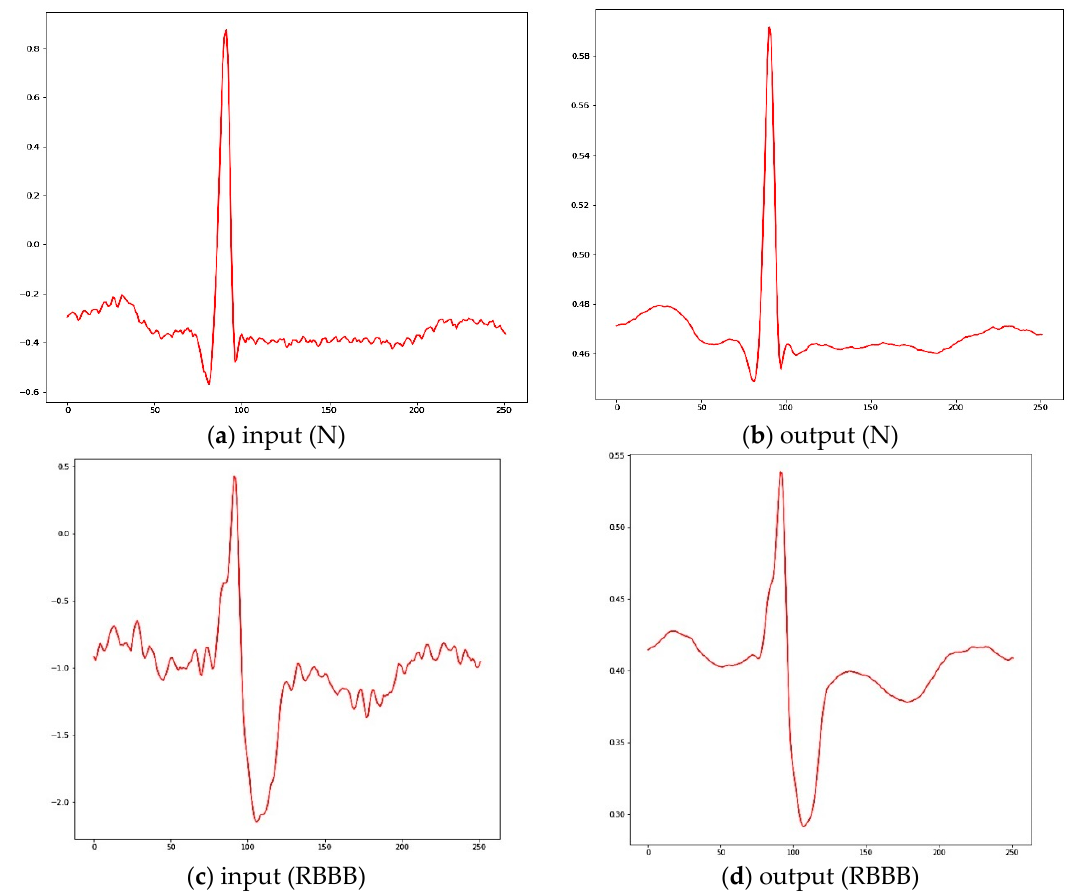
Figure 3. Sample of Auto Encoder reconstruction results.